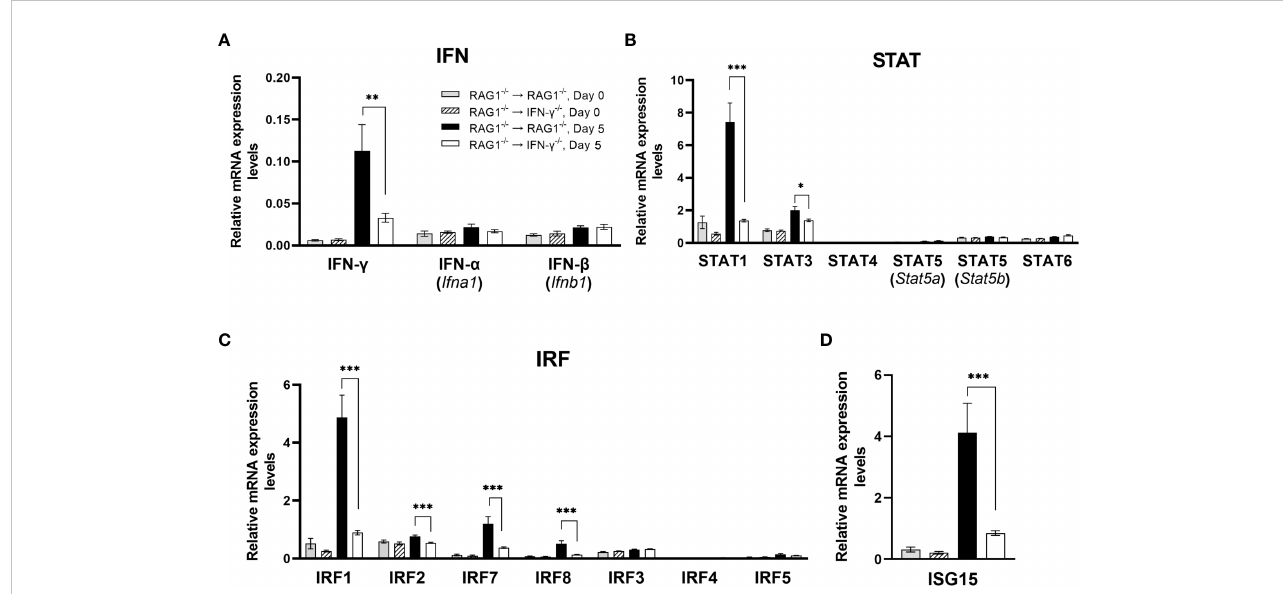
FIGURE 1 Cerebral mRNA levels for IFN- g -mediated signaling pathway are upregulated only in the presence of brain-resident cells capable of producing IFN- g in response to reactivation of cerebral infection with T. gondii. RAG1 -/- → RAG1 -/- and RAG1 -/- → IFN- g -/- mice were infected orally with 10 cysts of the ME49 strain of T. gondii and treated with sulfadiazine in the drinking water (400 mg/L) beginning at 4-6 days after infection for 2-3 weeks to control the proliferation of tachyzoites and establish a chronic infection in their brains. Their brains were collected on the last day of sulfadiazine treatment (Day 0) and Day 5 after discontinuation of sulfadiazine (Day 5), which had initiated reactivation of the cerebral infection with T. gondii . The mRNA levels for (A) type I IFN (IFN- a and IFN- b ) and type II IFN (IFN- g ), (B) STAT1, 3, 4, 5 and 6, (C) IRF1, 2, 3, 4, 5, 7, and 8, and (D) ISG15 in the brains of both groups of mice at both Day 0 and Day 5 were measured using NanoString nCounter Mouse Myeloid Innate Immunity Panel. * P <0.05, ** P <0.01, and *** P <0.001. The data were combined from two independent experiments (n=5 for Day 0 and n=7 for Day 5 in both RAG1 -/- → RAG1 -/- and RAG1 -/- → IFN- g -/-